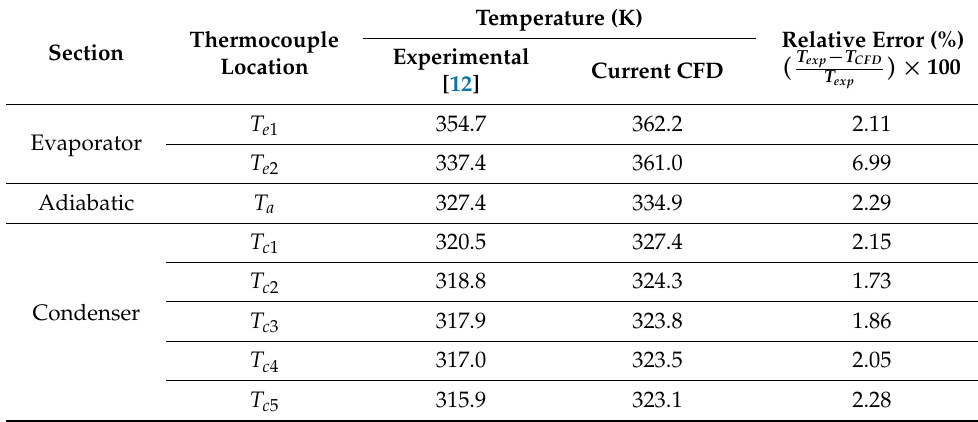
Table 3. Validation check based on temperature changes in the inner side of